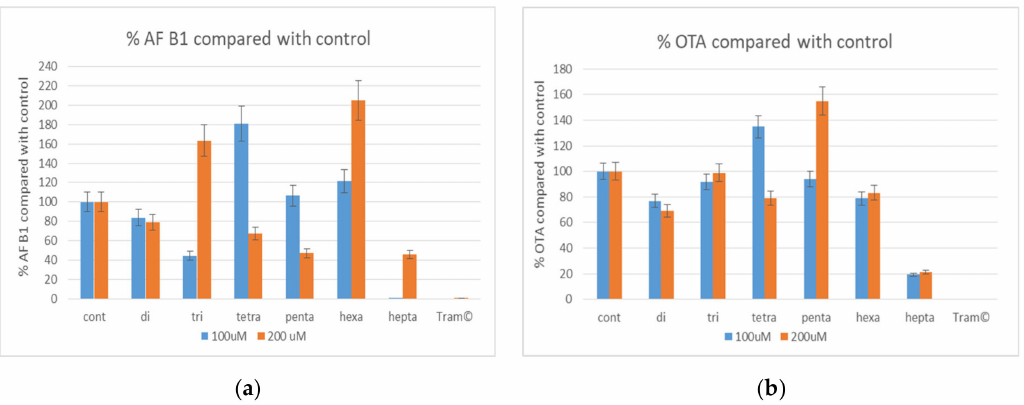
Figure 6. ( a , b ). Relative inhibition by different oligosaccharides and Tramesan © of Aflatoxin B1 ( a ) and Ochratoxin A ( b ) production by A. flavus NRRL 3357 and A. carbonarius strain. Bars represent the mean ± SD of three determinations of five sep- arate experiments. (cont—control; di—disaccharides; tri—trisaccharides; tetra—tetrasaccharides;